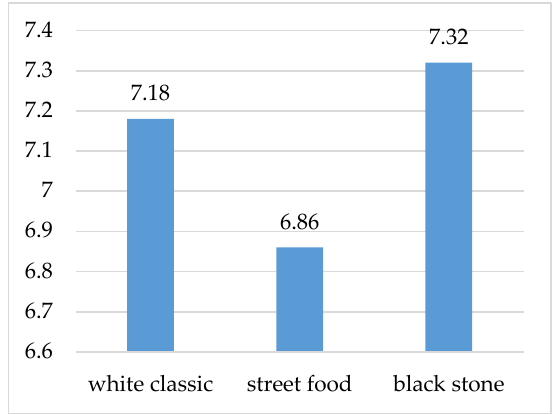
Figure 10. Evaluation of aromas of individual waffle variants.